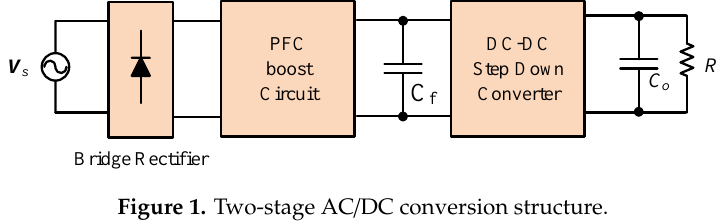
Figure 1. Two-stage AC/DC conversion structure.